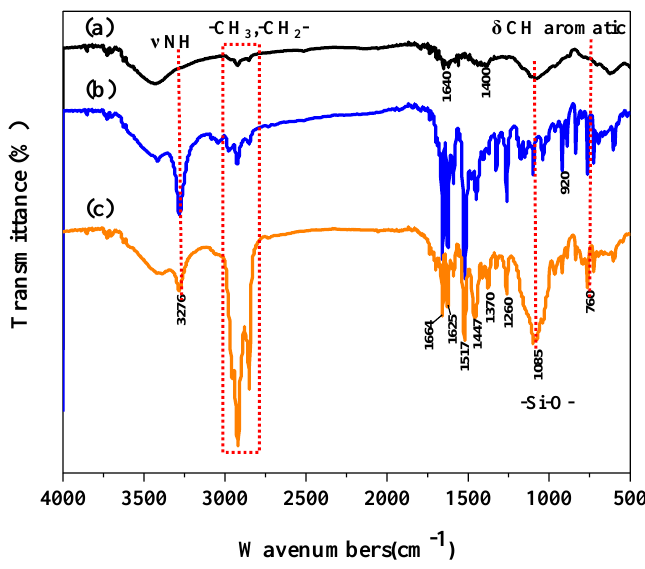
Figure 3. FTIR spectra of VTES ( a ), FGMAC ( b ) and PFMV ( c ).